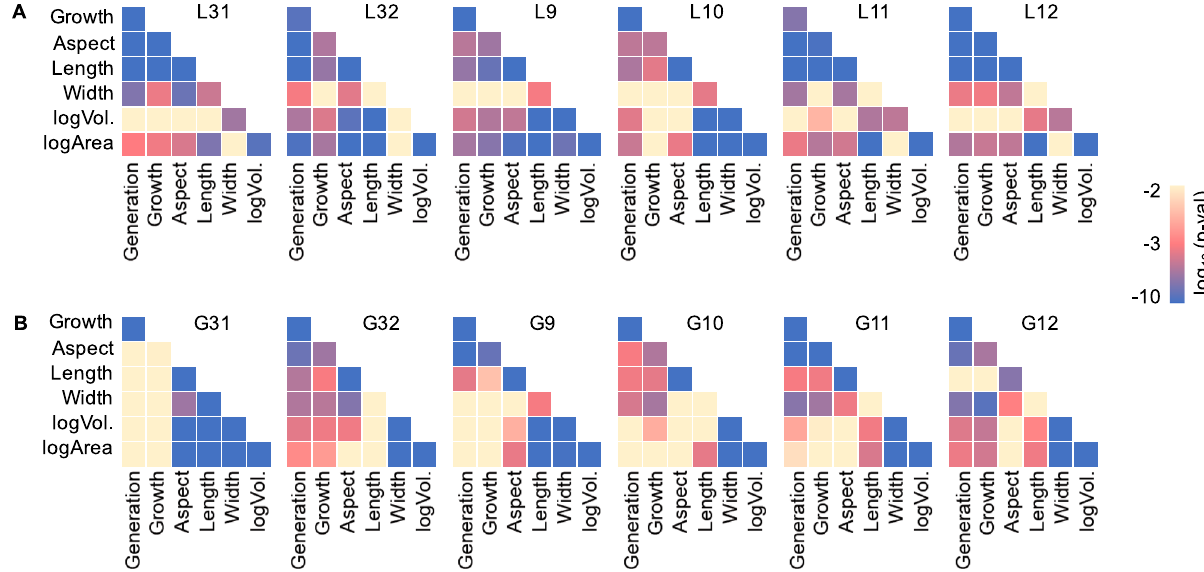
Fig. 3 Correlations between growth and morphology. The statistical signi fi cance of the correlation coef fi cients between any two out of six features, which represented the growth and the morphology, is shown in the heatmap. The colour gradient from yellow to blue indicates statistical signi fi cance. Blue and purple are highly signi fi cant. The six features growth, aspect, length, width, logArea, and logVol. represent the growth rate, aspect ratio, relative cell length ( L ), relative cell width ( W ), and logarithms of the area ( A ) and calculated cell volume ( V ), respectively. The six lineages evolved in either OAVs ( A ) or glucose ( B ) are indicated. The calculated data are summarized in the Supplementary Data 2 and Supplementary Data